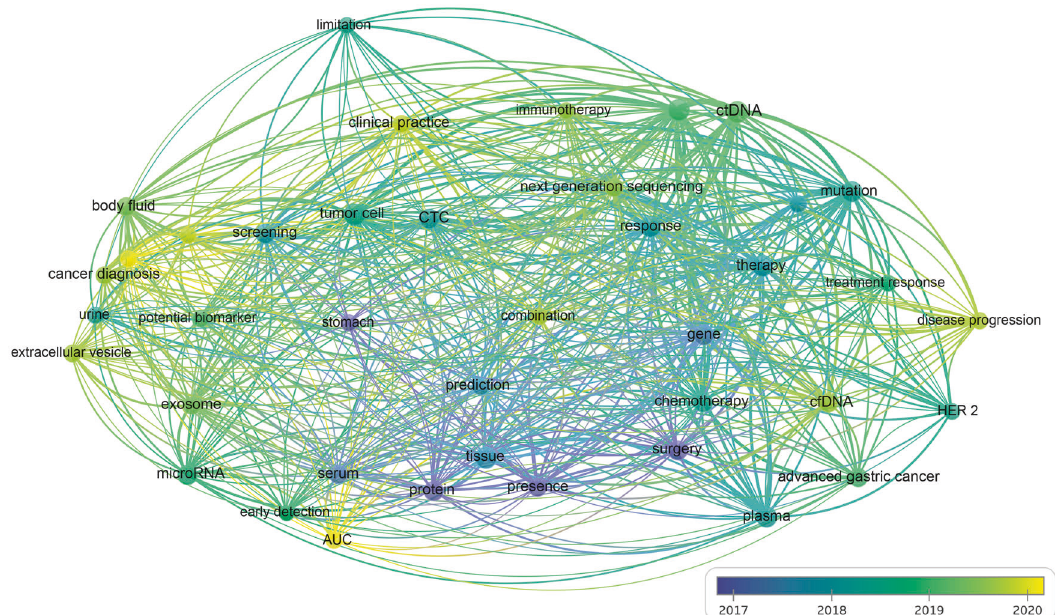
Fig. 3 Network and timing analysis based on published literature. Articles published on the Web of Science in the past fi ve years were retrieved and results were visualized through bibliometric methods by VOSviewer and CiteSpace. “ Gastric cancer ” and “ Liquid biopsy ” are set as keywords to draw the network and time series diagrams to analyze the development trends in this fi eld. Each node represents different research content. The size of each node indicates the frequency of occurrence, the thickness of the connection between the nodes indicates the strength of the association, and the different color represent the temporal characteristics of the